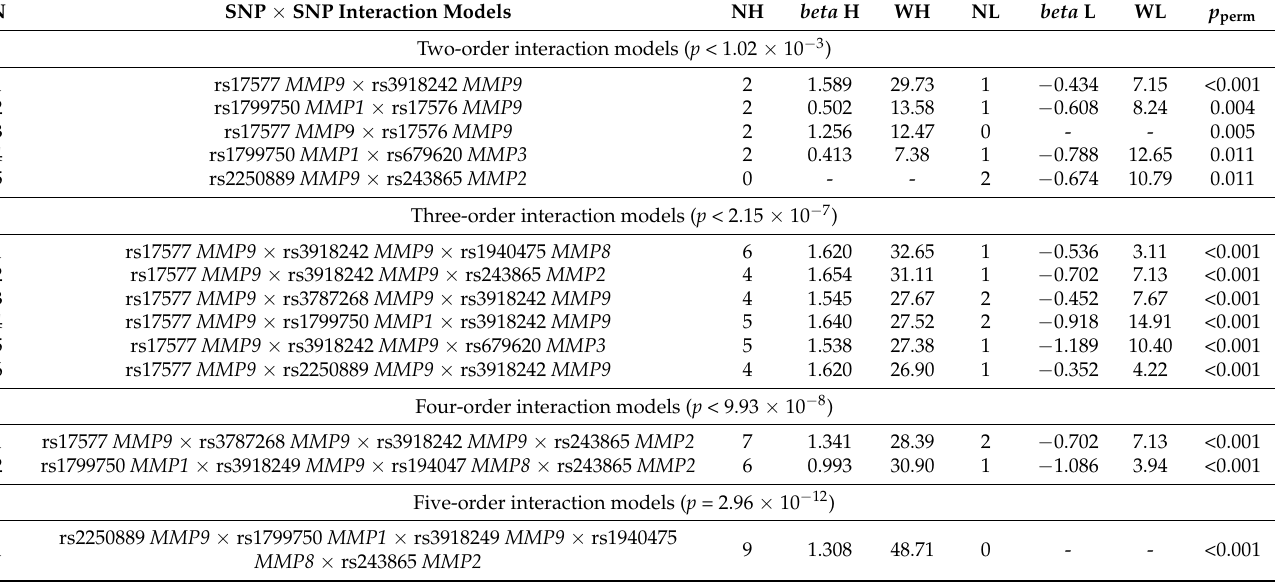
Table 4. SNP × SNP interactions significantly associated with breast